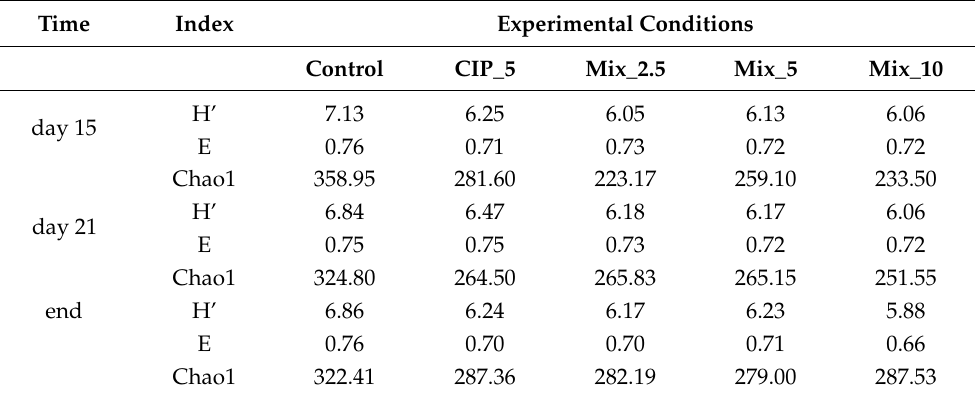
Table 2. Shannon Weaver diversity index (H’), Pielou’s evenness index (E) and Chao index calculated for all experimental conditions at days 15, 21 and at the end of the experiment.